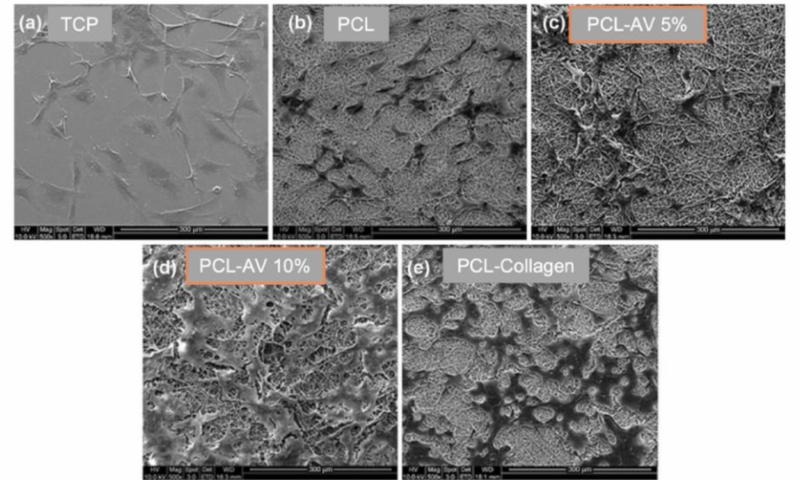
Figure 3. Fibroblast interaction with Aloe vera (AV)-based nanofibrous scaffolds. This figure shows different mesh structures infused with AV at 5% and 10% and collagen. The interactions of fibroblasts with the mesh surface are measured using scanning electron microscopy (SEM). The dark patches within each image are indicative of the fibroblasts. Reproduced with permission from [64], copyright Iran Polymer and Petrochemical Institute,